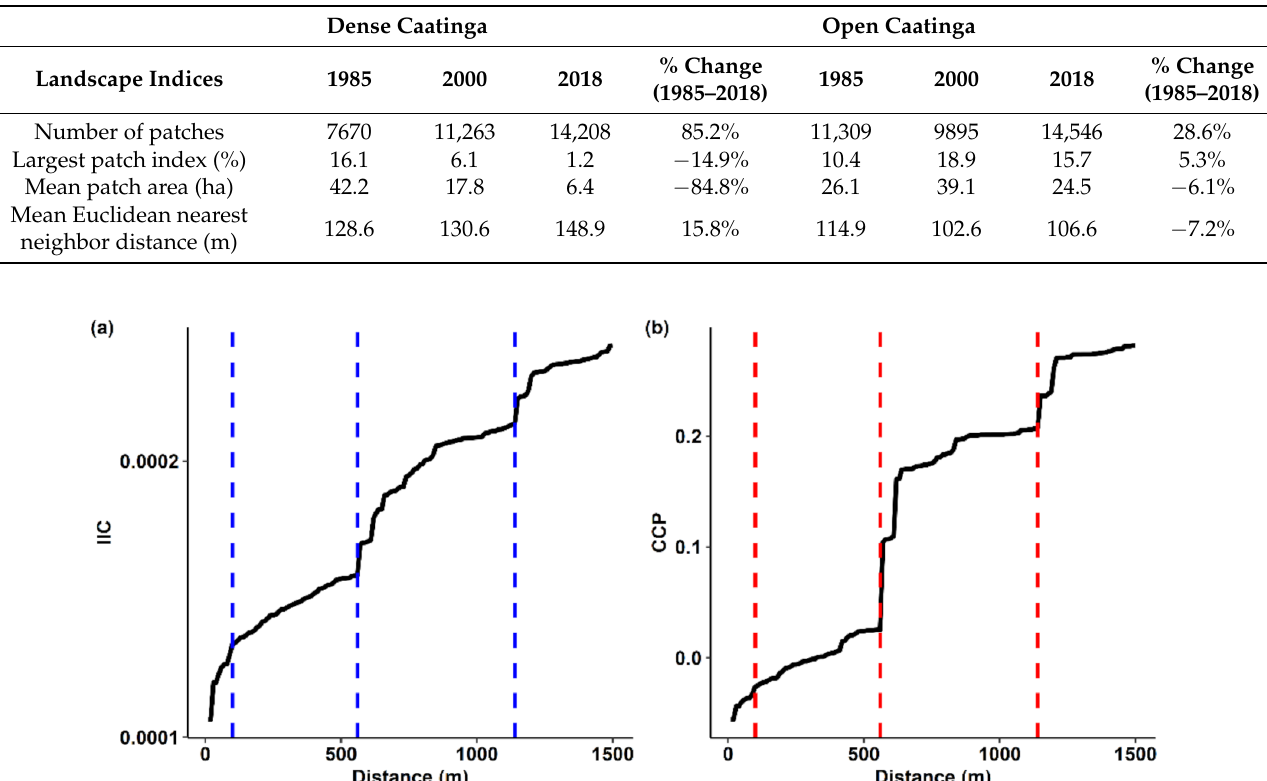
Table 1. Changes in landscape pattern indices for the native vegetation in the study area in 1985, 2000, and 2018.